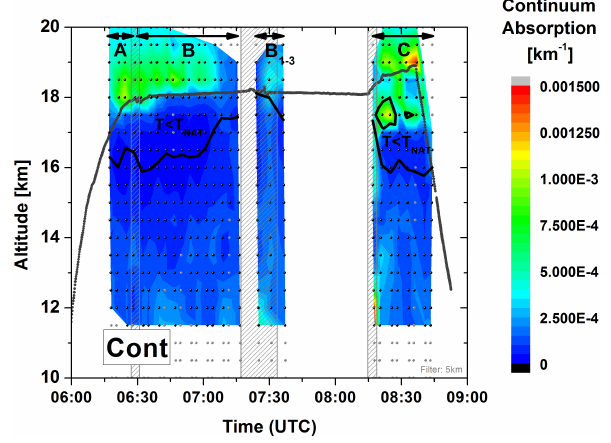
Figure 5. Vertical cross section of continuum absorption re- trieved from the MIPAS-STR observations associated with the flight on 25 January 2010. Enhanced continuum absorption indicates cloud/aerosol particles. Other parameters as in Fig. 4 (from Woi- wode PhD thesis, 2013, with modifications).